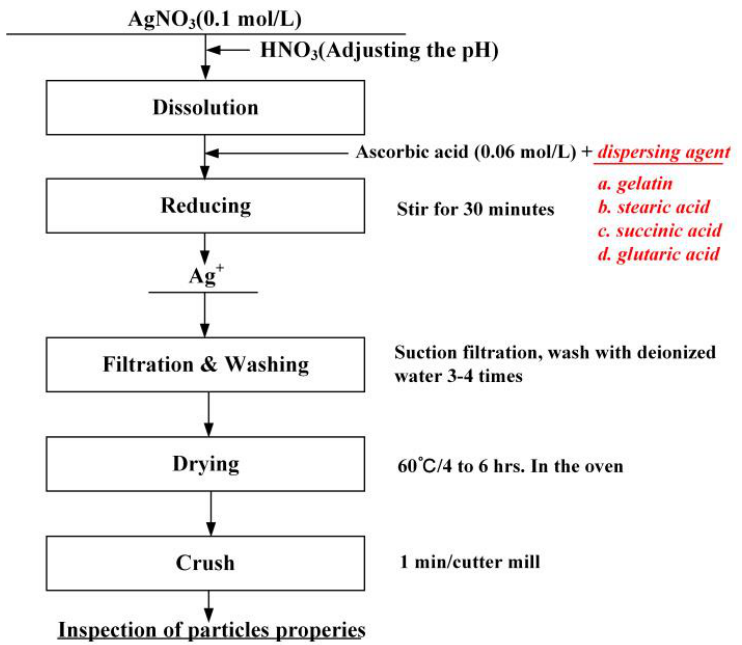
Figure 2. Synthetic flow chart for preparation of monodispersed silver particles.